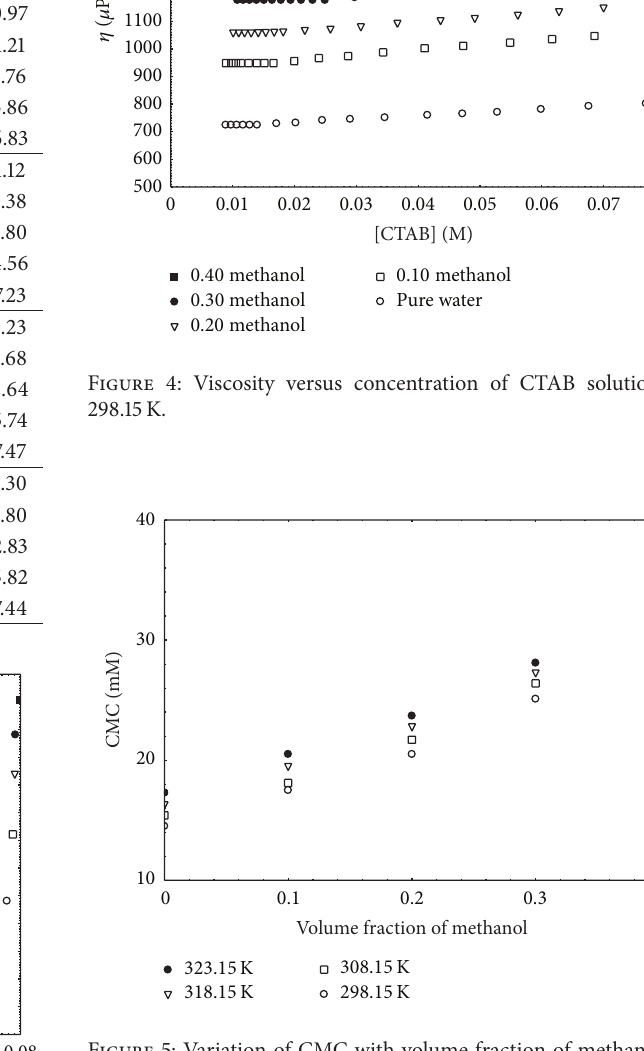
Figure 5: Variation of CMC with volume fraction of methanol of DTAB solution at different